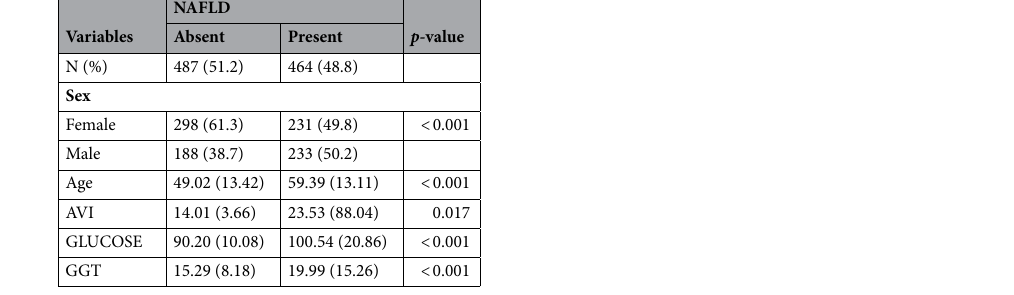
Table 3. Sample subset characteristics by NAFLD condition. NUTRIHEP study, Castellana Grotte (BA), Italy, 2015. Cells reporting subject characteristics contain mean (± SD) or n (%).